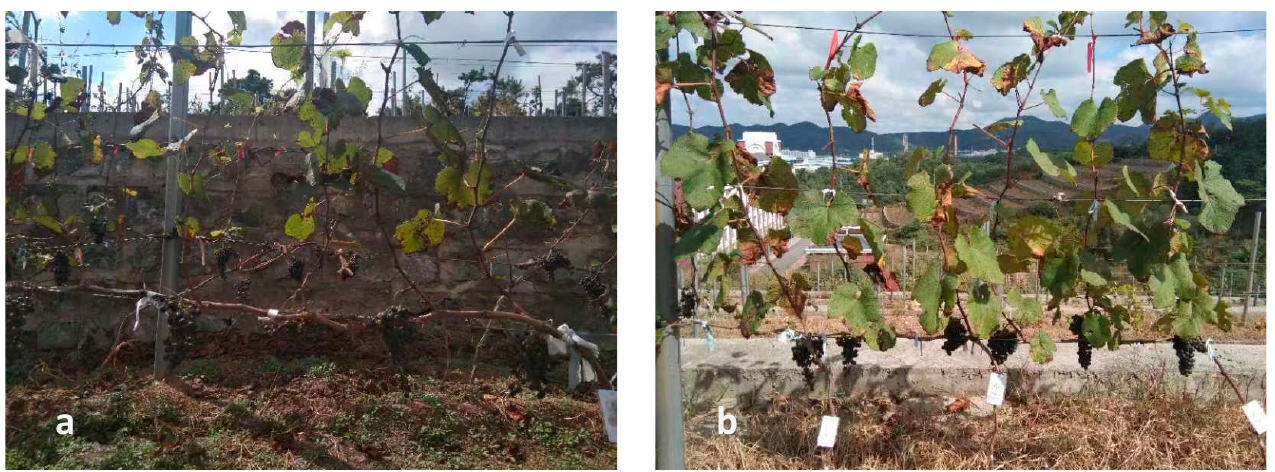
Figure 2. Beibinghong vines subjected to leaf removal at véraison: ( a ) compared with untreated vines or ( b ) the control.